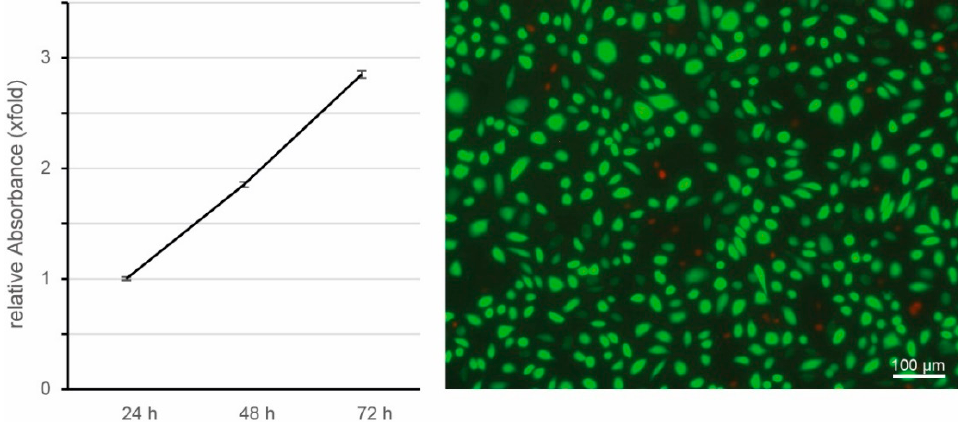
Figure 9. Cytocompatibility of silk fibroin films: Left : XTT assay for cell viability and proliferation of L929 cells cultivated on films from silk fibroin for 24 h, 48 h, and 72 h, respectively. The mean cell metabolic activity and standard error of the mean are reported for three independent silk fibroin samples dissolved with ZnCl 2 in triplicates. Right : Representative fluorescence microscopy image of live-dead staining of L929 cells after 72 h cultivated on films from silk fibroin dissolved in ZnCl 2 .